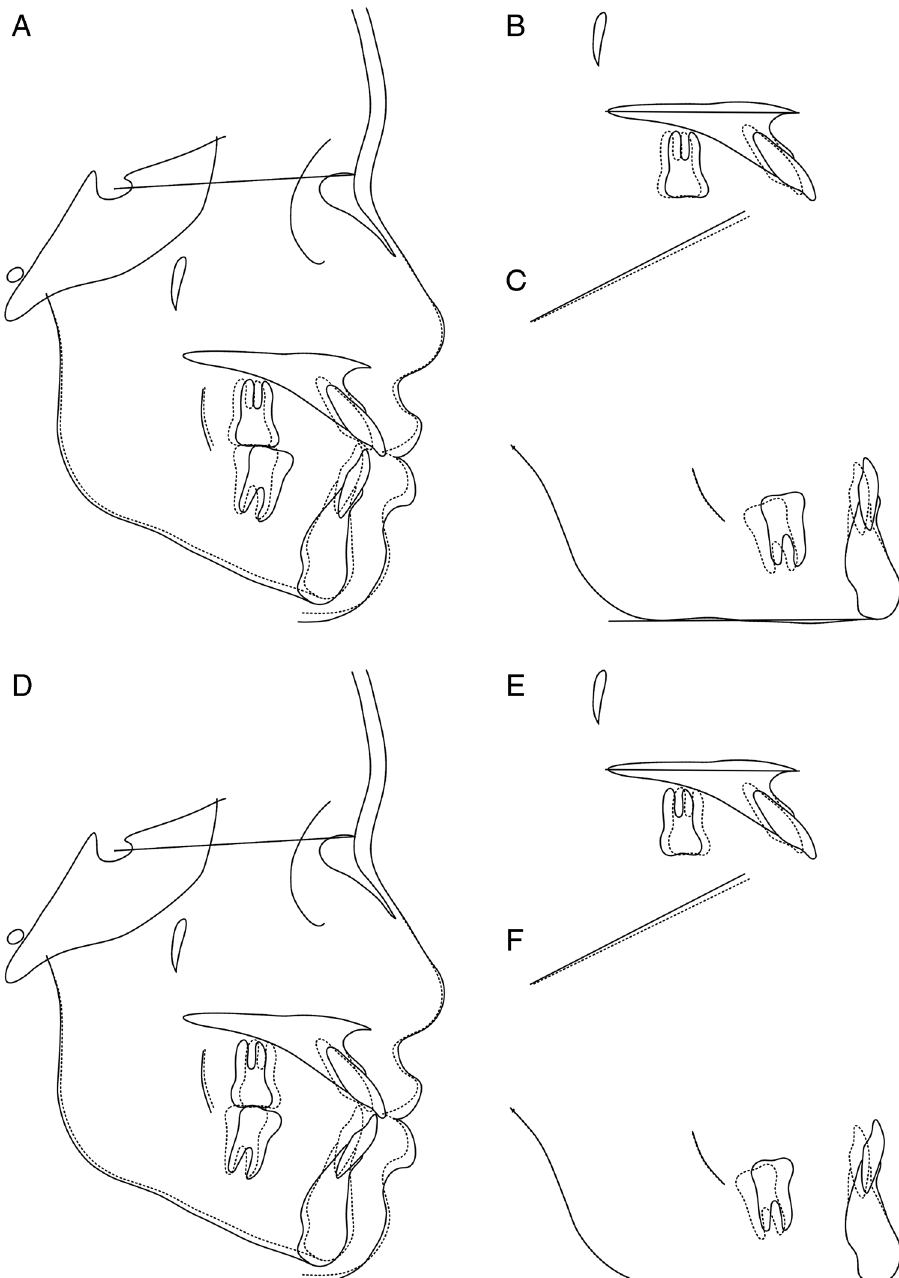
Figure 9. Superimposition of the cephalometric tracings obtained at pretreatment (solid line) and posttreatment (dotted line). (A, D) The sella-nasion plane at the sella. (B, E) The palatal plane at the ANS. (C, F) The mandibular plane at the menton. (A–C) The right incisors and molars. (D–F) The left incisors and